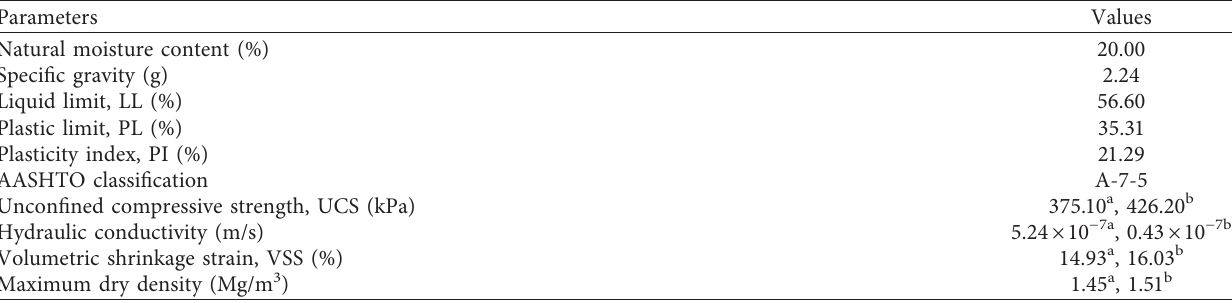
Table 1: Geotechnical properties of the untreated shale.